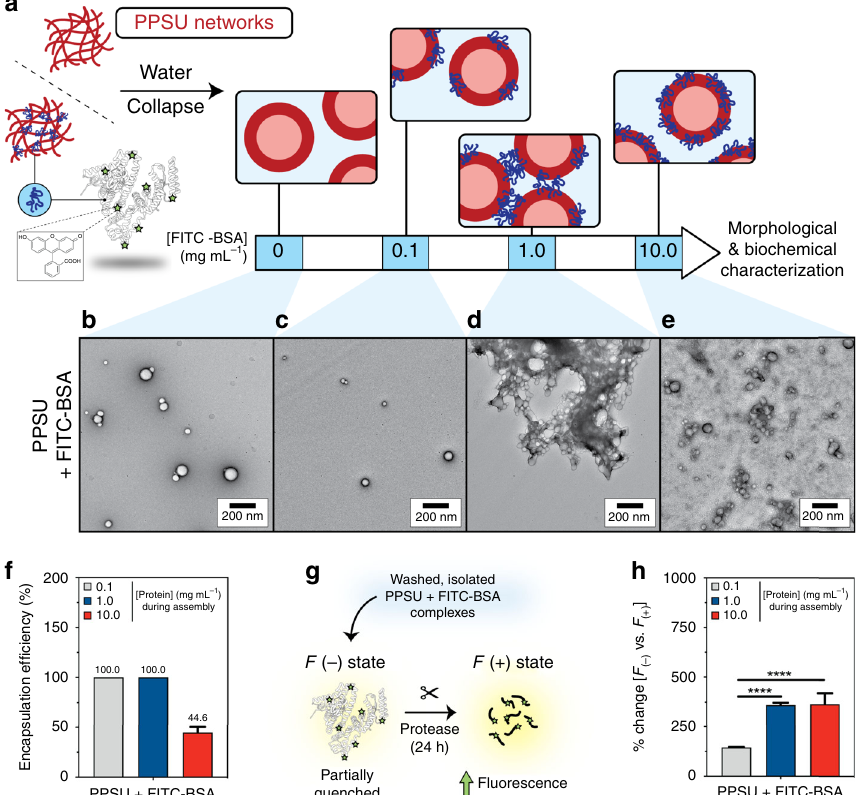
Fig. 4 Encapsulation of protein in PPSU nanogels. a PPSU 20 nanostructures (5 mg) were assembled with a concentration series of aqueous FITC-BSA at 0.1, 1.0, or 10 mg mL − 1 (1.6, 16, and 160% w/w protein/PPSU). PPSU 20 nanostructures prepared without protein (0 mg mL − 1 FITC-BSA) were included as a control. b – e Transmission electron microscopy of negatively stained specimens. b PPSU 20 nanostructures absent of protein. PPSU-FITC-BSA complexes assembled in the presence of ( c ) 0.1, ( d ) 1.0, or ( e ) 10.0 mg mL − 1 FITC-BSA (purposefully overloaded sample and the free FITC-BSA was not